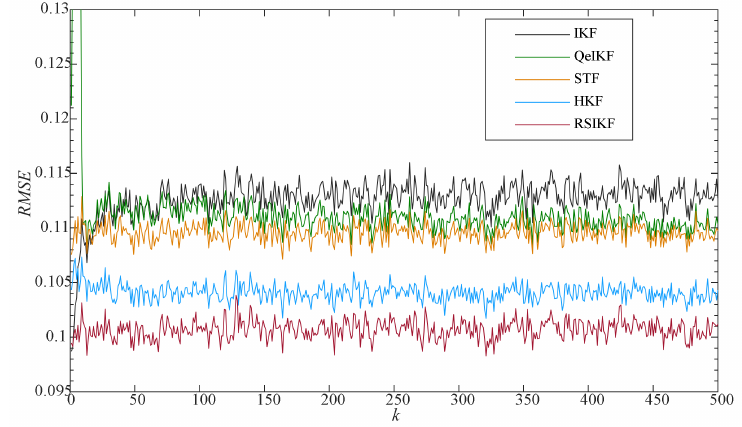
Figure 9. The RMSE k result of different methods for the case of α = 20 and β = 10.